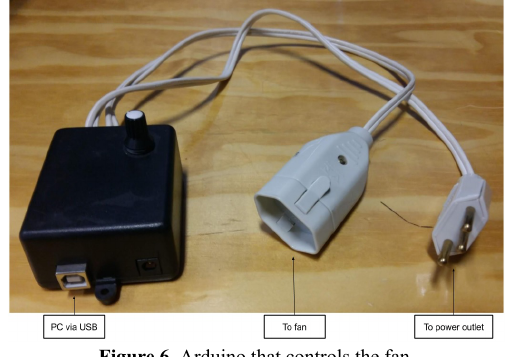
Figure 6. Arduino that controls the fan.